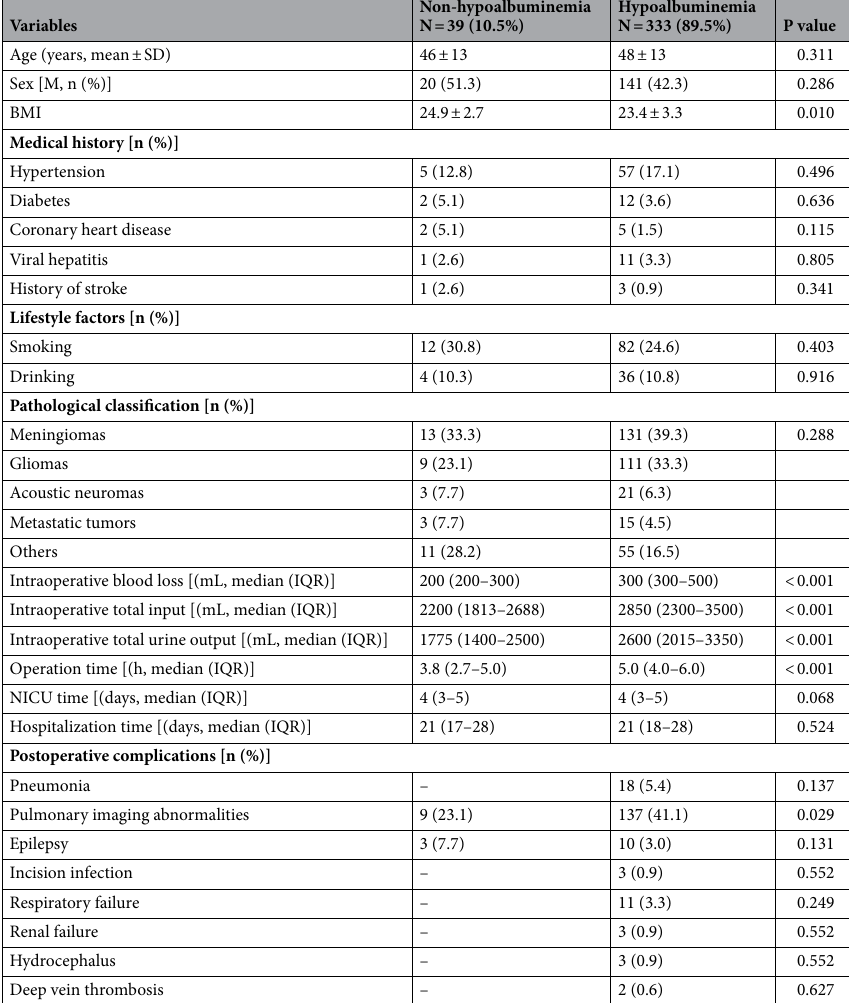
Table 1. Demographic and clinical characteristics between with and without hypoalbuminemia patients underwent craniotomy for brain tumor. BMI Body Mass Index, NICU Neurological Intensive Care Unit, SD standard deviation, IQR interquartile